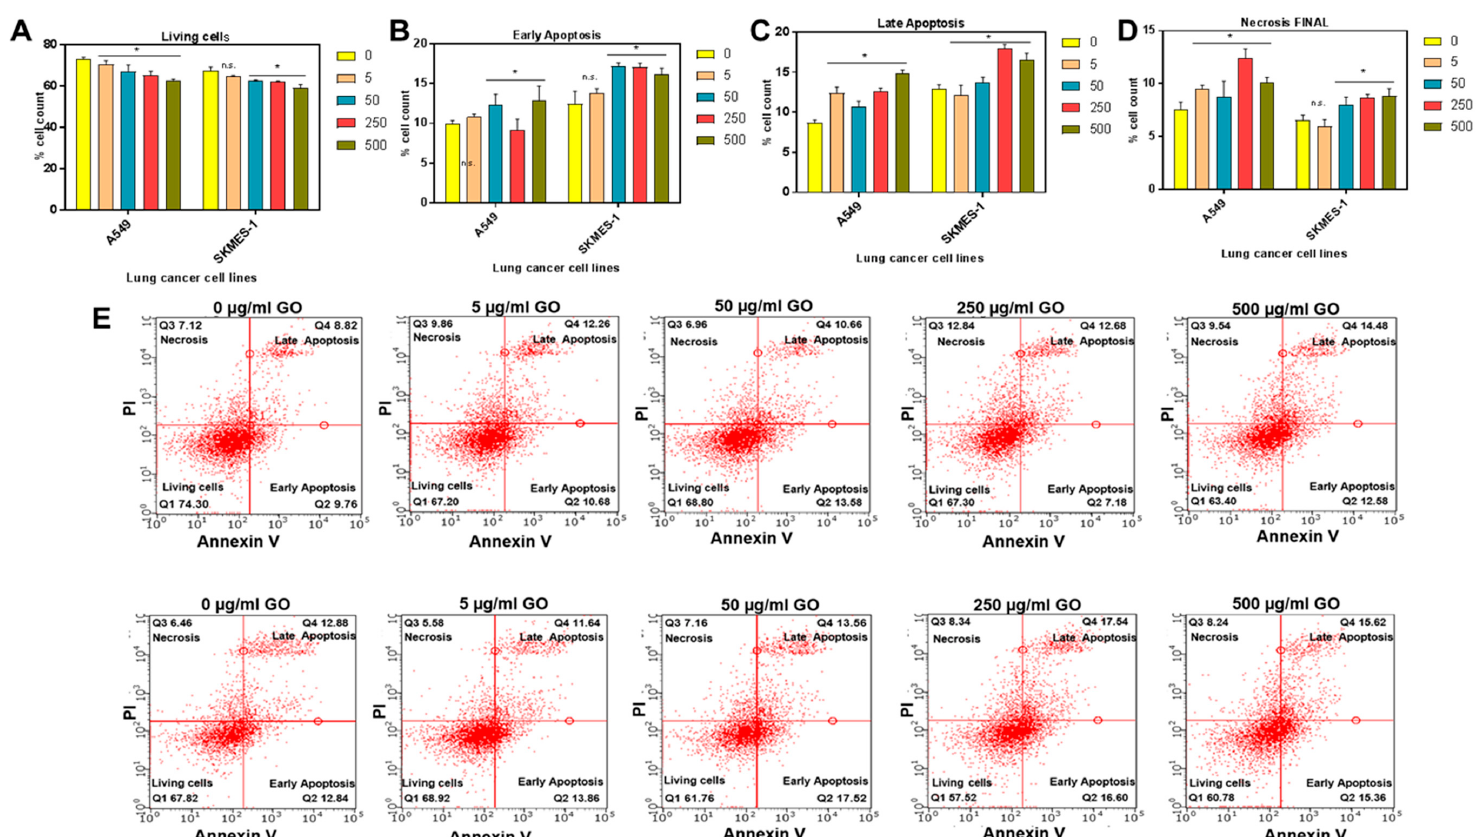
Figure 2. The percentages of living, apoptotic and necrotic lung cancer cells (A549 and SKMES-1) ± graphene oxide (GO) treatment. Cells were stained with annexin V (apoptosis) and propidium iodide (PI; late apoptosis and necrosis) following 24 h of treatment with varying concentrations of GO (0–500 µg/mL) and was assessed by flow cytometry and analysed using Guava 3.1.1 software. Percentage cell counts are shown for ( A ) living cells, ( B ) early apoptosis, ( C ) late apoptosis and ( D ) necrosis at increasing concentrations of GO. Data from three independent experiments are presented as mean ± SD. Groups are indicated as n.s and * p < 0.05, representing the outcomes of statistical tests vs control (0 µg/mL). ( E ) Shows scatterplots from one representative experiment in A549 (upper panel) and SKMES-1 (lower panel) cells.